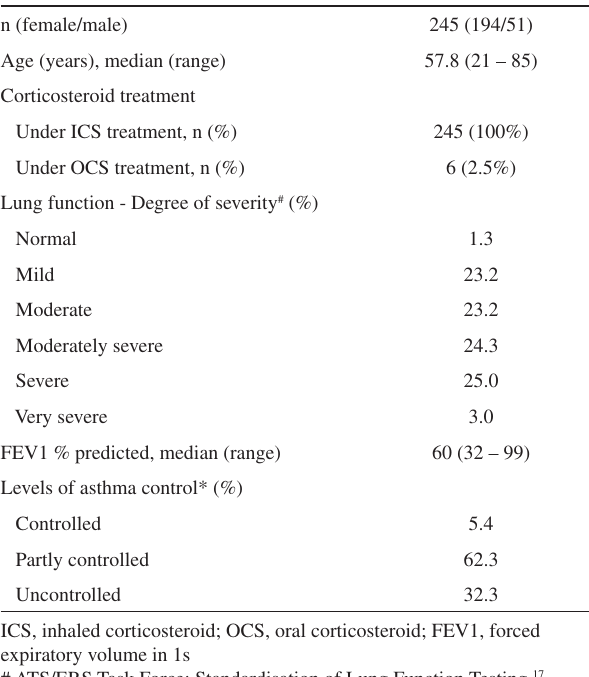
Table 1 - Demographic data, baseline characteristics, corti- costeroid treatment and lung function (all patients)